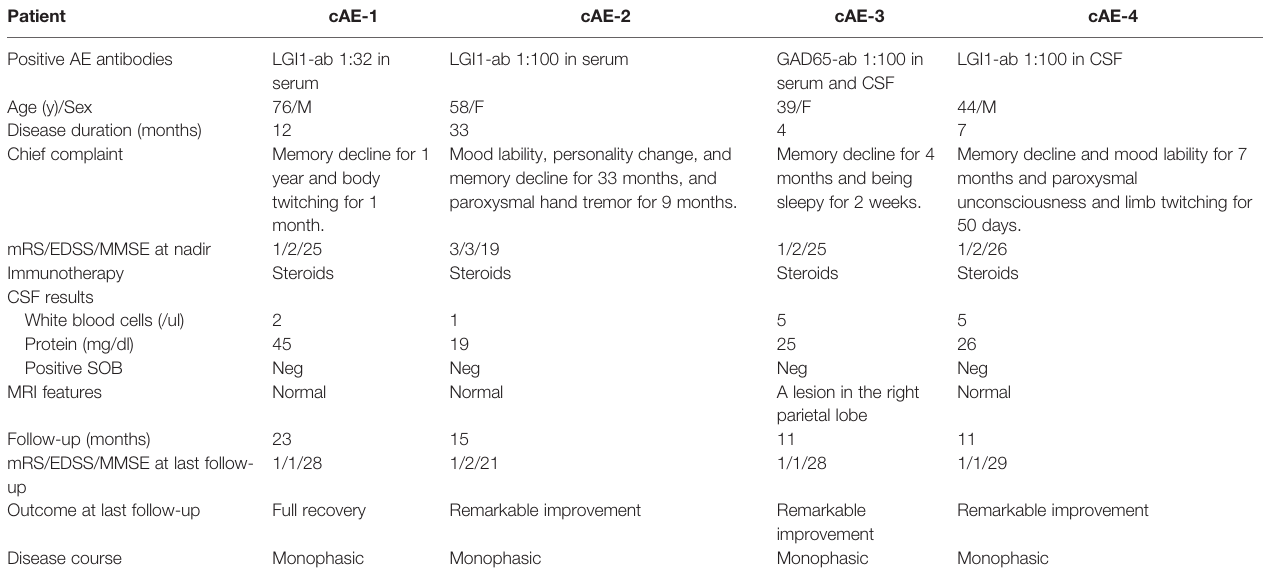
TABLE 3 | Demographic, clinical, imaging, characteristics, and treatment of four patients with